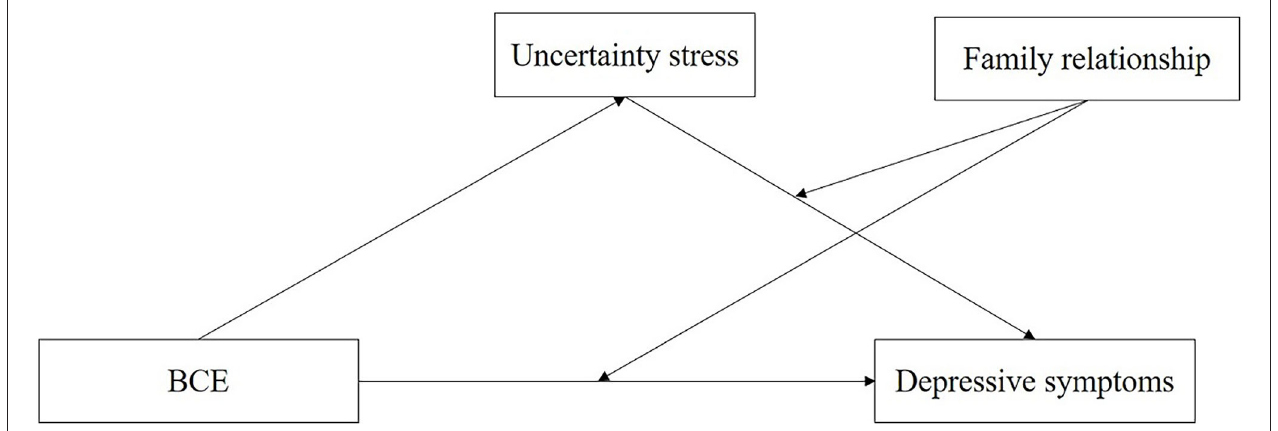
FIGURE 1 | The hypothesis model of the relationships between BCE, uncertainty stress, family relationship, and depressive